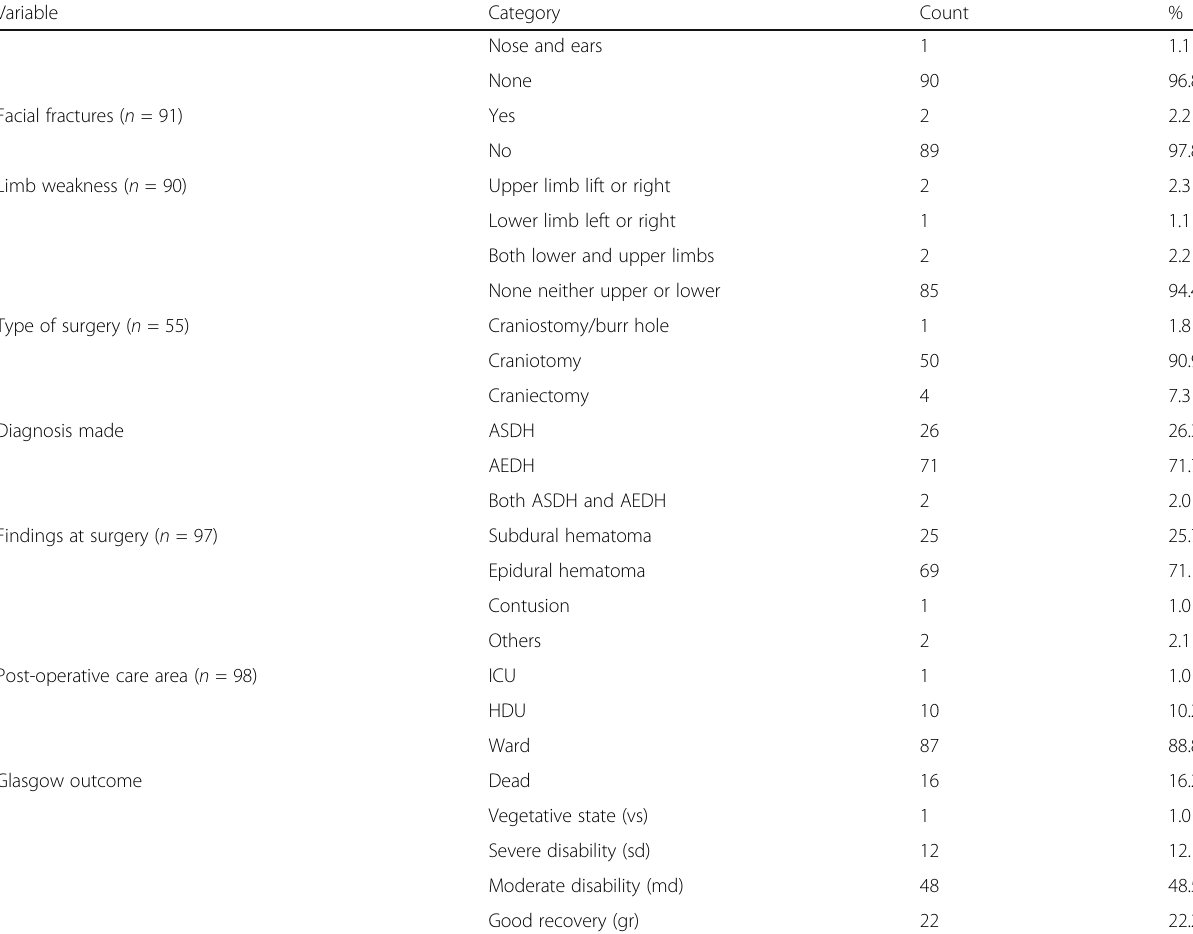
Table 1 Baseline demographic and clinical characteristics of patients with extra-axial haematoma at Mulago NRH (Continued) Variable